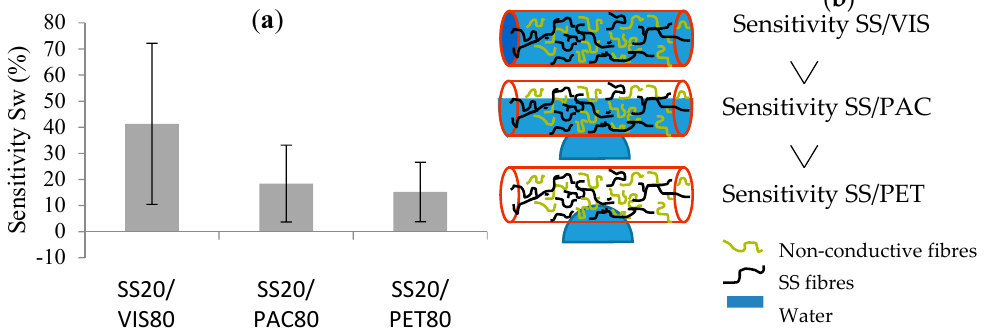
Figure 8. Principle of absorption: influence of hydrophilic property of the non-conductive fibres in the SS-spun yarns: ( a ) detector sensitivity ( Sw ); ( b ) hypothesis of the behaviour of the water-detector yarn.